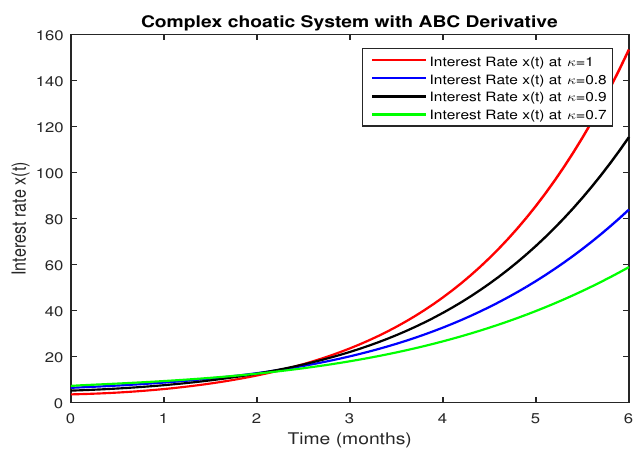
Figure 4. x ( t ) interest rate with ABC derivative.